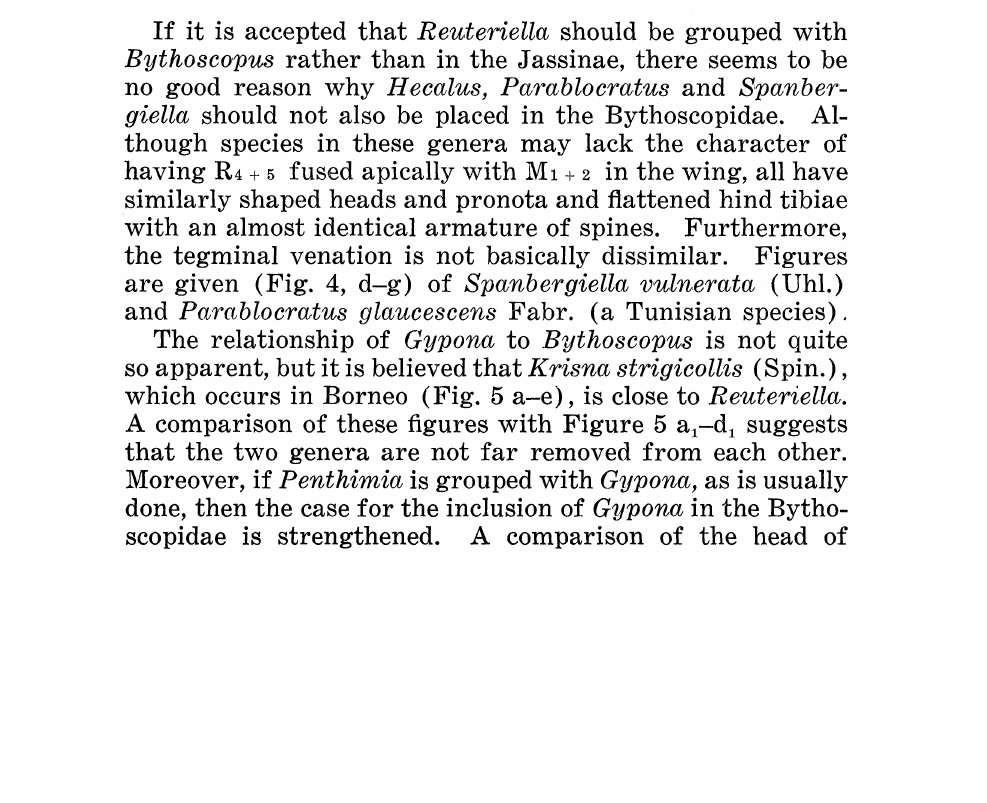
Figure 3. Reuteriella flavescens; c, d,